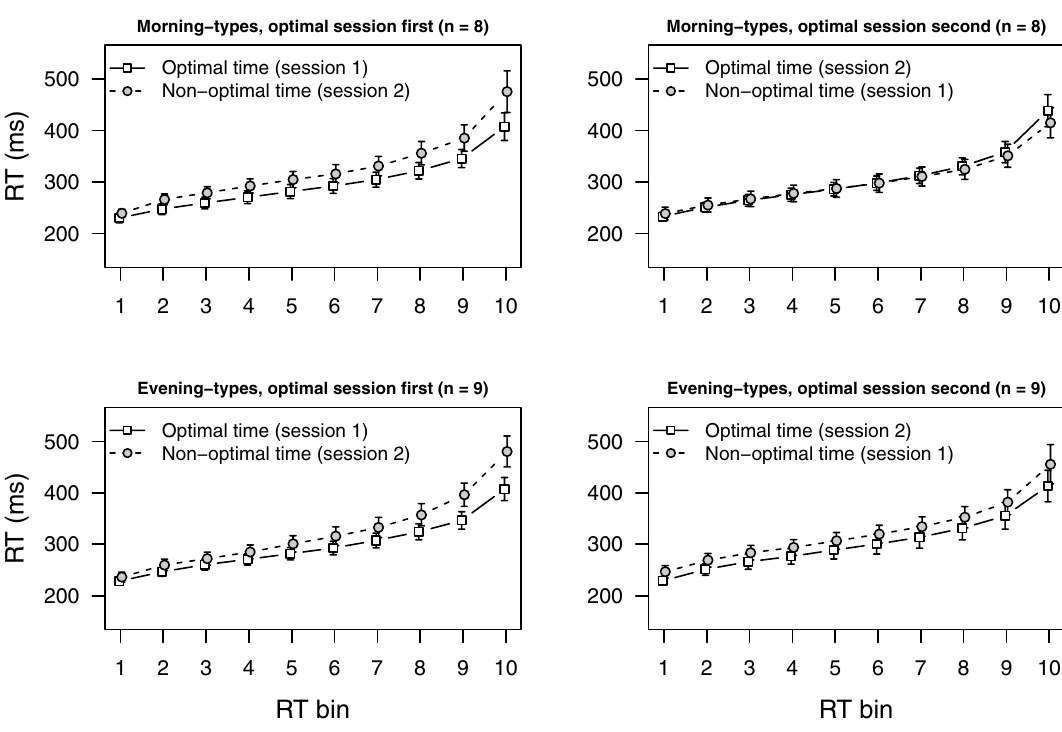
Figure 1. Mean reaction time (RT) in the psychomotor vigilance task, PVT (error bars represent standard error of the